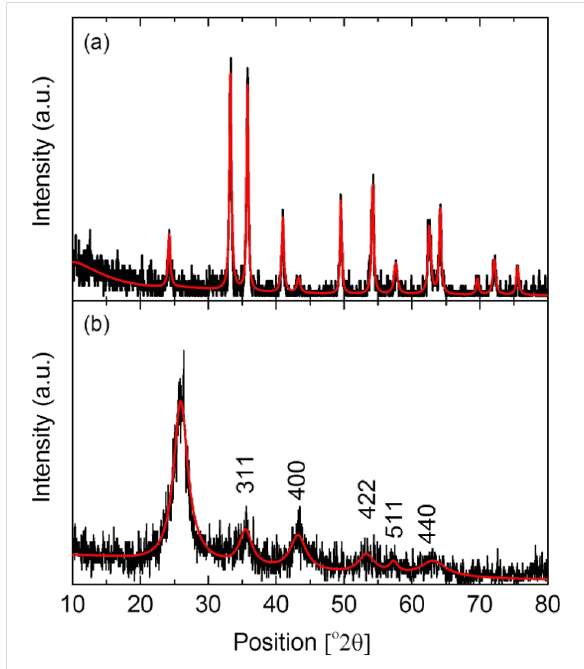
Figure 6: XRD pattern for Fe 2 O 3 nanoparticles (a) and decorated CNTs with Fe 2 O 3 nanoparticles (b).